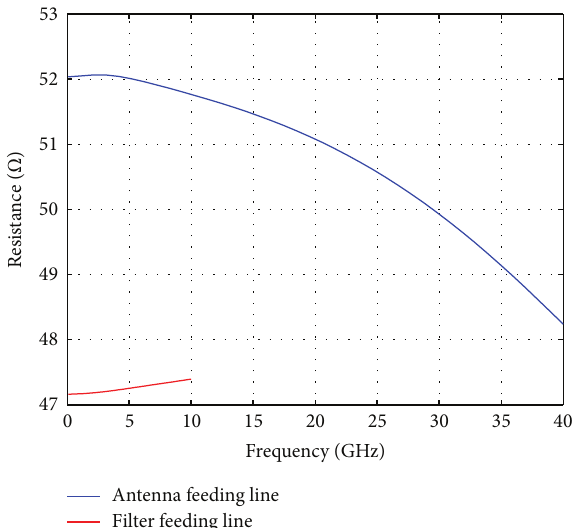
Figure 2: Calculated input impedance of the coplanar waveguide from Figure